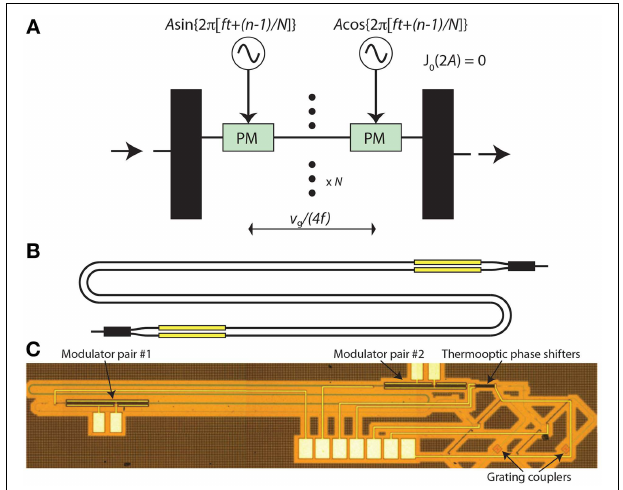
FIGURE 12 | (A) configuration of an optical isolator that uses a tandem arrangement of phase shifters. There are N arms in the interferometer. The